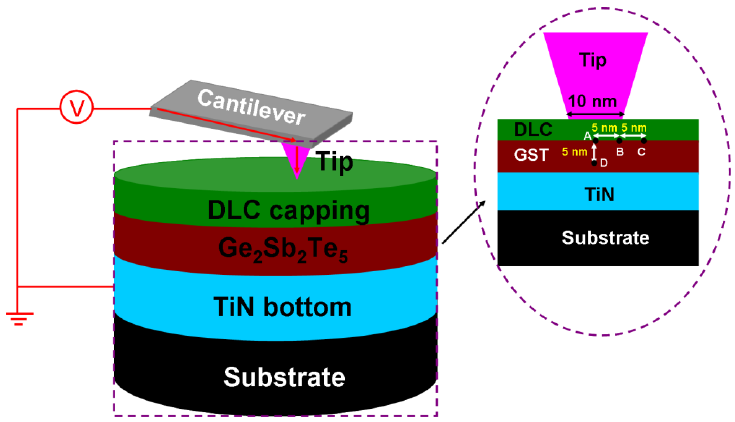
Figure 2. The 3D modeling geometry of the electric probe memory and its cross section (inset) where GST represents Ge 2 Sb 2 Te 5 .